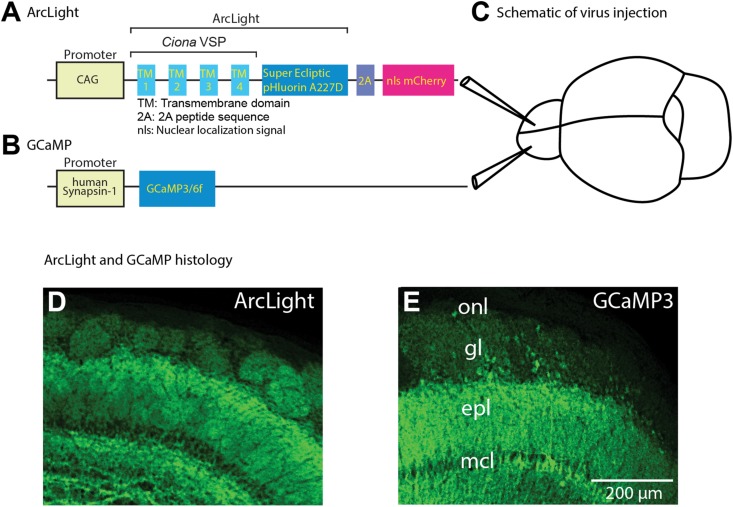
Schematic of viral vector constructs, virus injections to target both olfactory bulbs, and histological examination of ArcLight and GCaMP fluorescence. (A,B) Schematic drawing of the panel (A) ArcLight and (B) GCaMP3/6f AAV1 constructs. (C) ArcLight and GCaMP AAV vectors were injected into opposite hemibulbs of the same mouse between 10 and 50 days prior to imaging. (D,E) Confocal histological images demonstrate the expression patterns resulting from injecting the ArcLight (D) and GCaMP3 AAV vectors (E). The scale bar in k also applies to h. onl, olfactory nerve layer; gl, glomerular layer; epl, external plexiform layer; mcl, mitral cell layer. Modified from Storace et al. (2015).